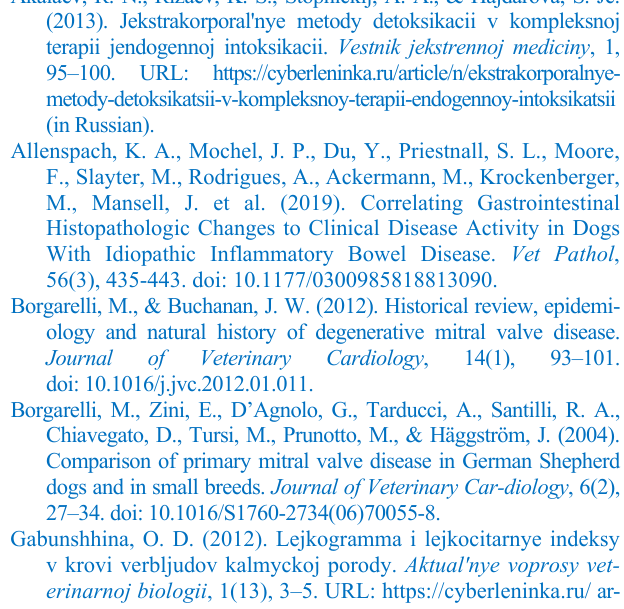
Conclusion on the condition of the animal after 2 weeks of treatment